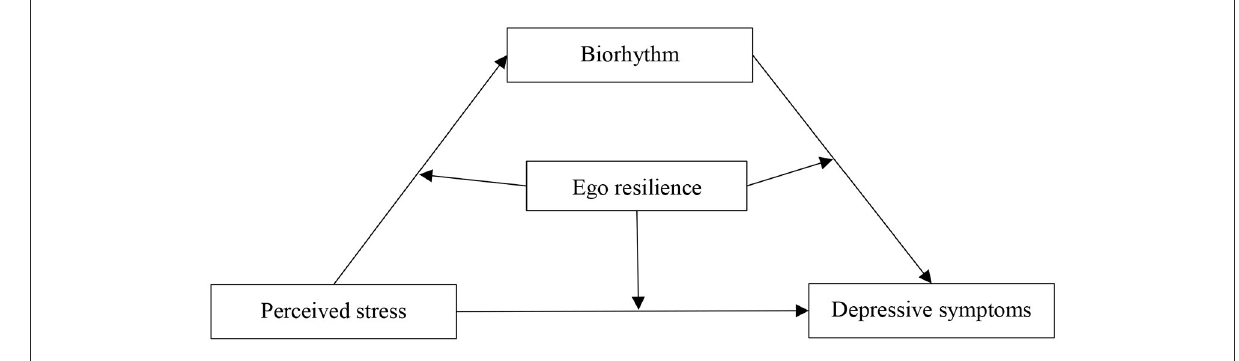
FIGURE1 Conceptual moderating mediation